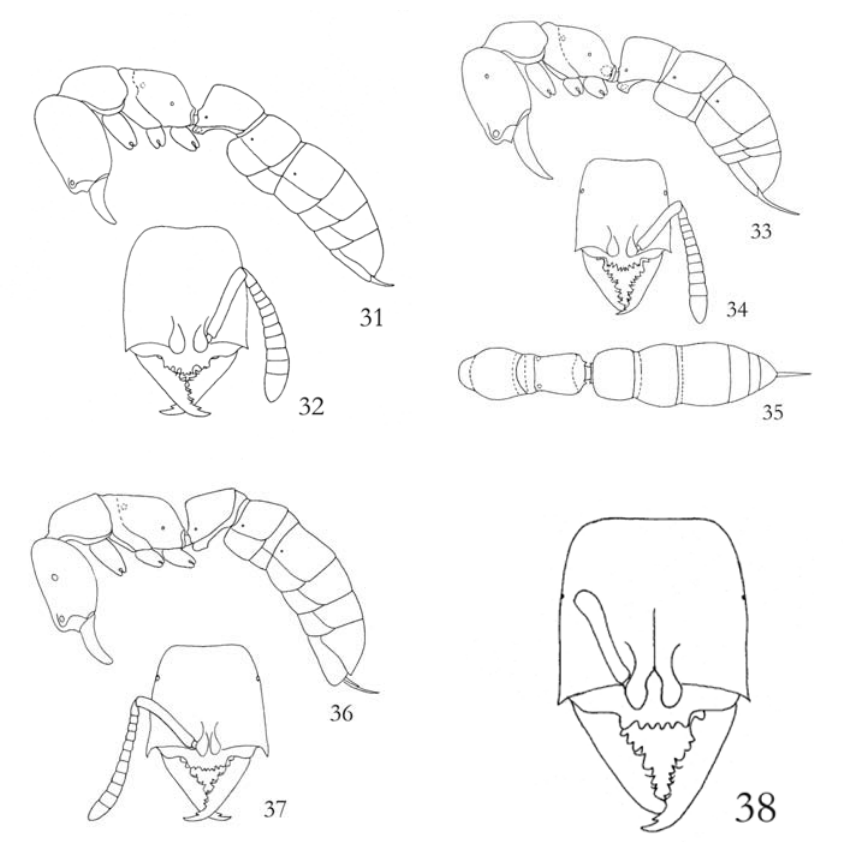
Figs.31-38. 31-32: Worker of Amblyopone triloba Xu; 31. Head and body in profile view; 32. Head in full-face view. (Drawn from Antweb images). 33-35: Worker of Amblyopone meiliana sp. nov.; 33. Head and body in profile view; 34. Head in full-face view; 35. Body in dorsal view. 36-37: Worker of Amblyopone noonadan Taylor; 36. Head and body in profile view; 37. Head in full-face view. (Drawn from Antweb images). 38: Worker of Amblyopone amblyops (Karavaiev), head in full-face view. (Cited from Karavaiev, 1935, slightly